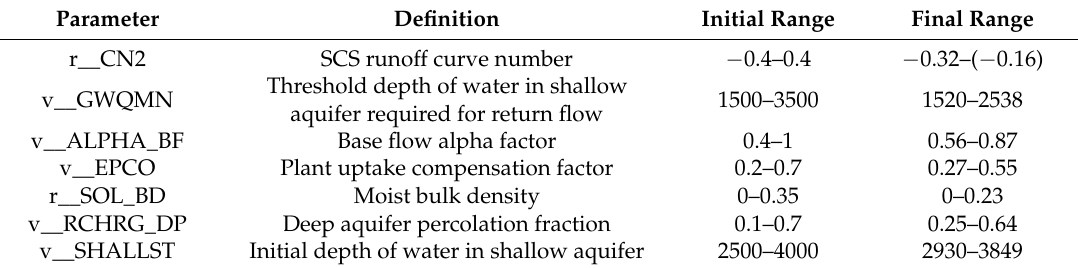
Table 2. Initial and final ranges of the seven most sensitive SWAT calibration parameters in the